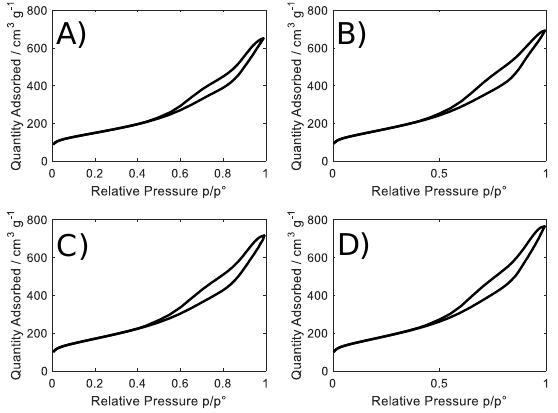
Figure 1. Adsorption and desorption nitrogen isotherms for ( A ) S_GA; ( B ) S_GA_Cu; ( C ) S_GA_Fe; and ( D ) S_GA_FeCu.